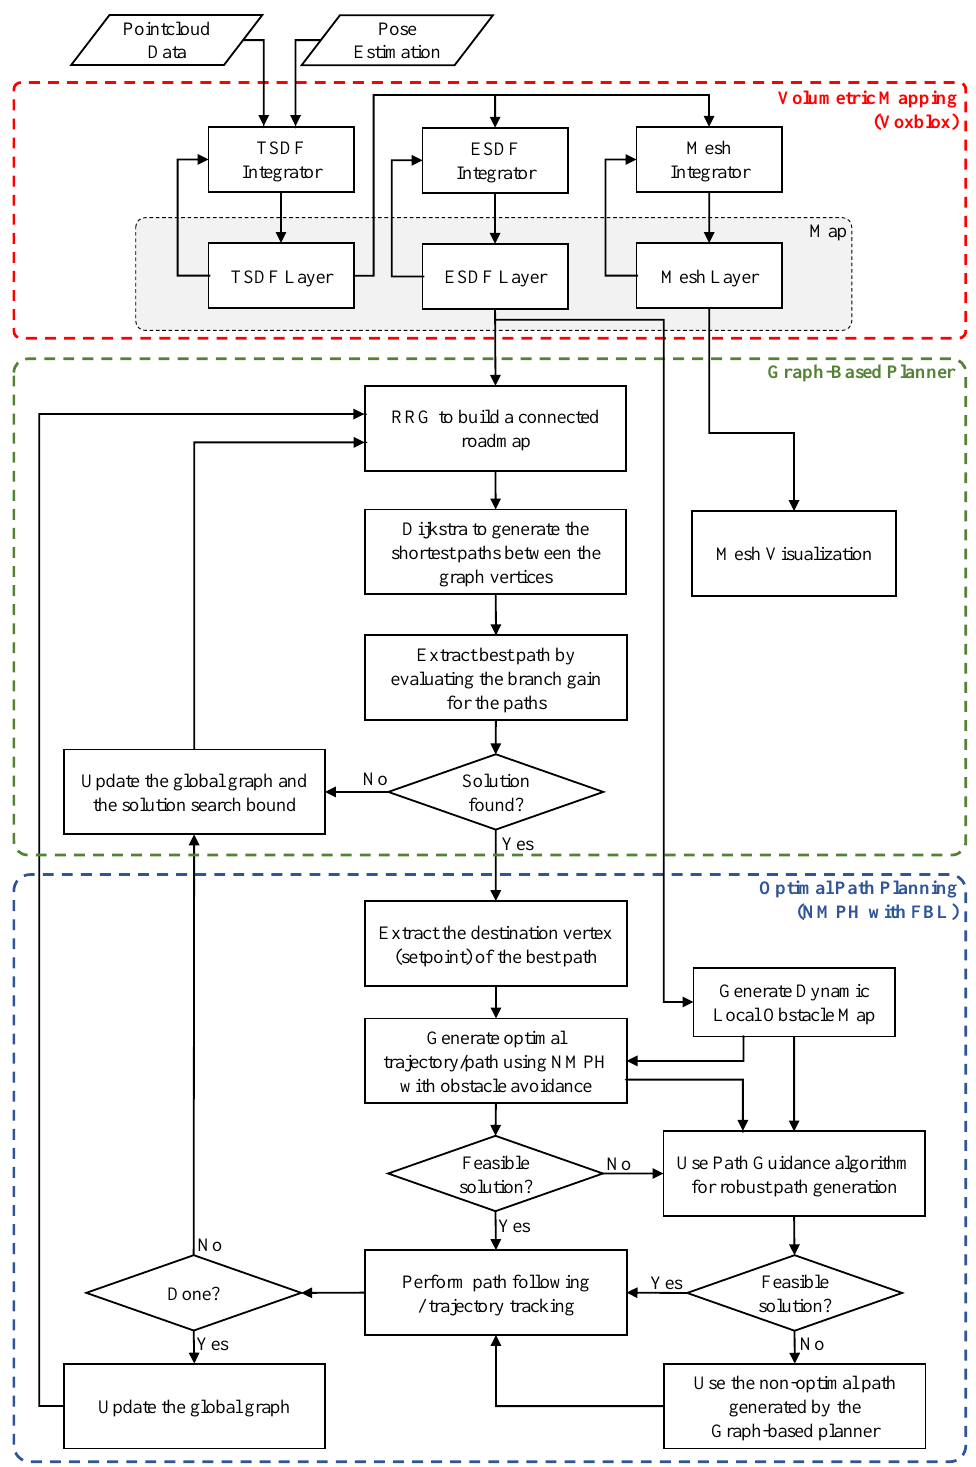
Figure 3. Motion Planner